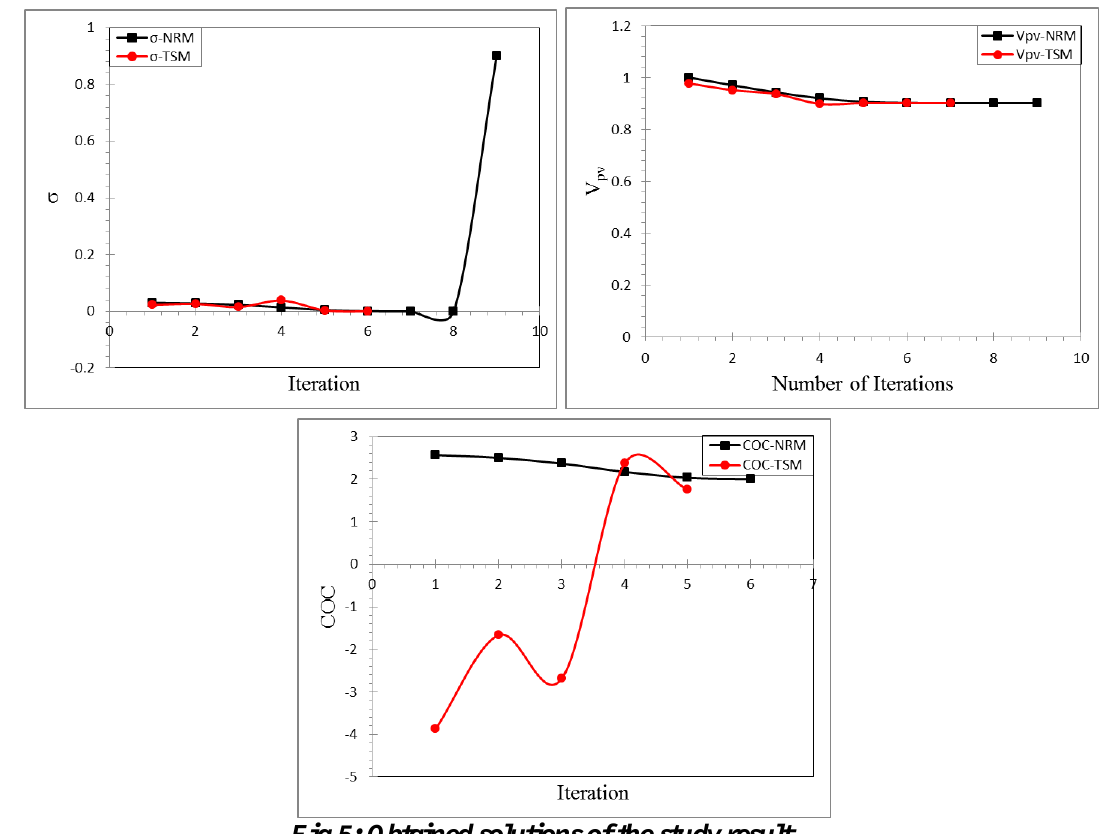
Fig.5: Obtained solutions of the study